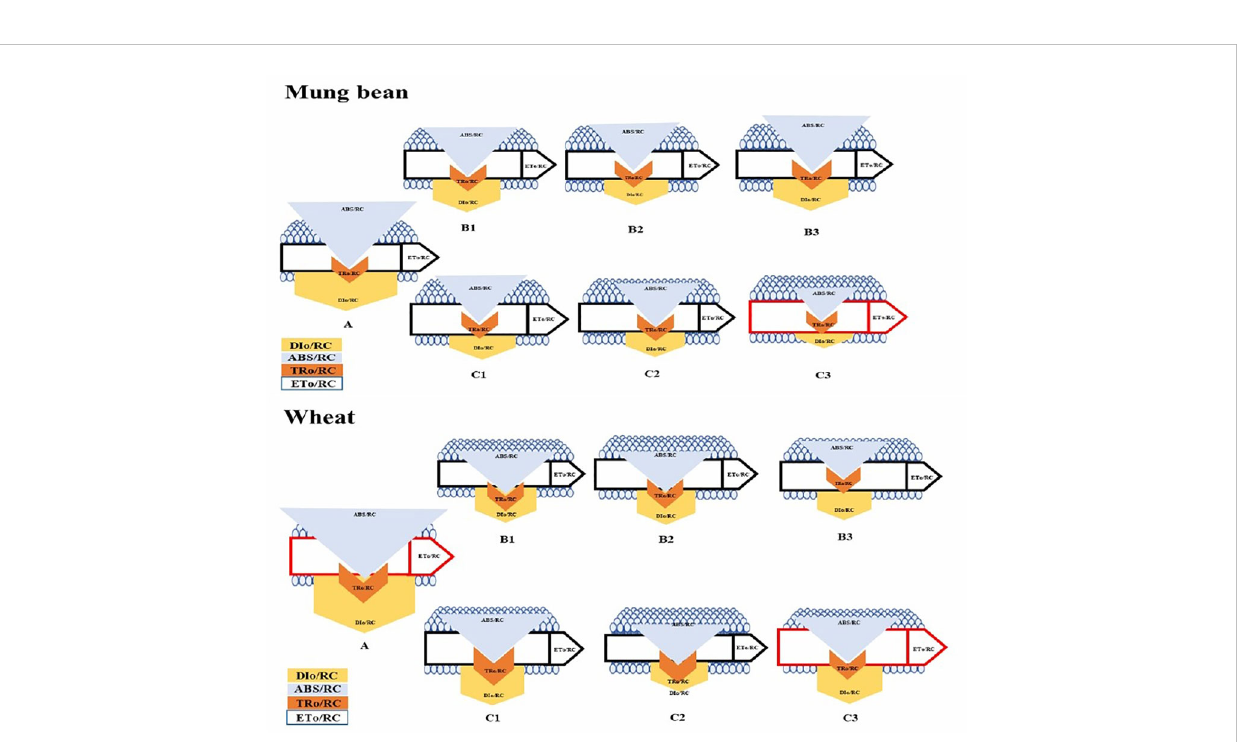
FIGURE 9 Membrane pipeline model showing the proportion of speci fi c energy fl uxes in treated plants. In the membrane, ABS/RC, TRO/RC, ETO/RC, and DIO/ RC indicate absorption, maximum trapped exciting fl ux per active PSII, electron transport, and dissipation fl ux, respectively. The value of each parameter can be seen in relative changes in the width of each arrow (see the color legend). The diagram exhibits the variation of ABS/RC, TRO/RC, ETO/RC, and DIO/RC, for seven treatments, namely, A=200mM, B1=200mM and Paecilomyces lilacinus strain with 5 minutes time interval, B2=200mM and Paecilomyces lilacinus strain with 10 minutes time interval, B3=200mM and Paecilomyces lilacinus strain with 15 minutes time interval, C1=200mM and Trichoderma harzianum strain with 5 minutes time interval, C2=200mM and Trichoderma harzianum strain with 10 minutes time interval, and C3=200mM and Trichoderma harzianum strain with 15 minutes time interval. The model displays fl uxes in different shapes; the size of each shape was developed by the different values of four fl uxes in each